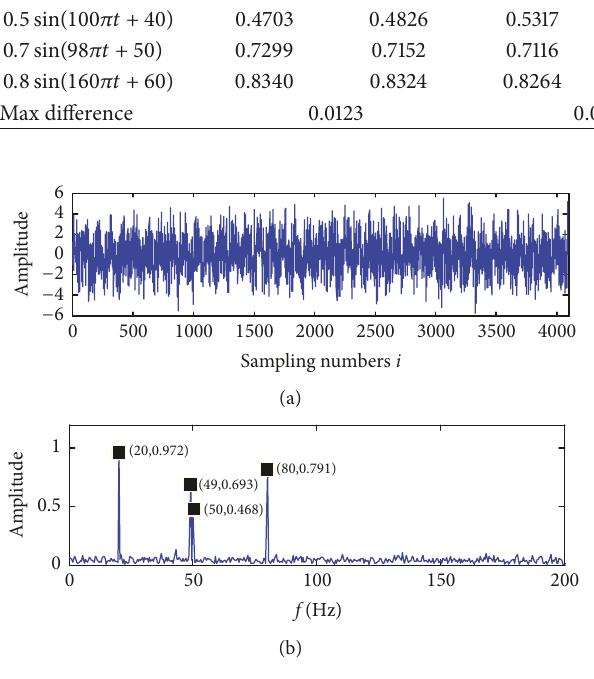
Figure 4: The raw signal 𝑦 . (a) Time domain. (b) Amplitude spectrum.